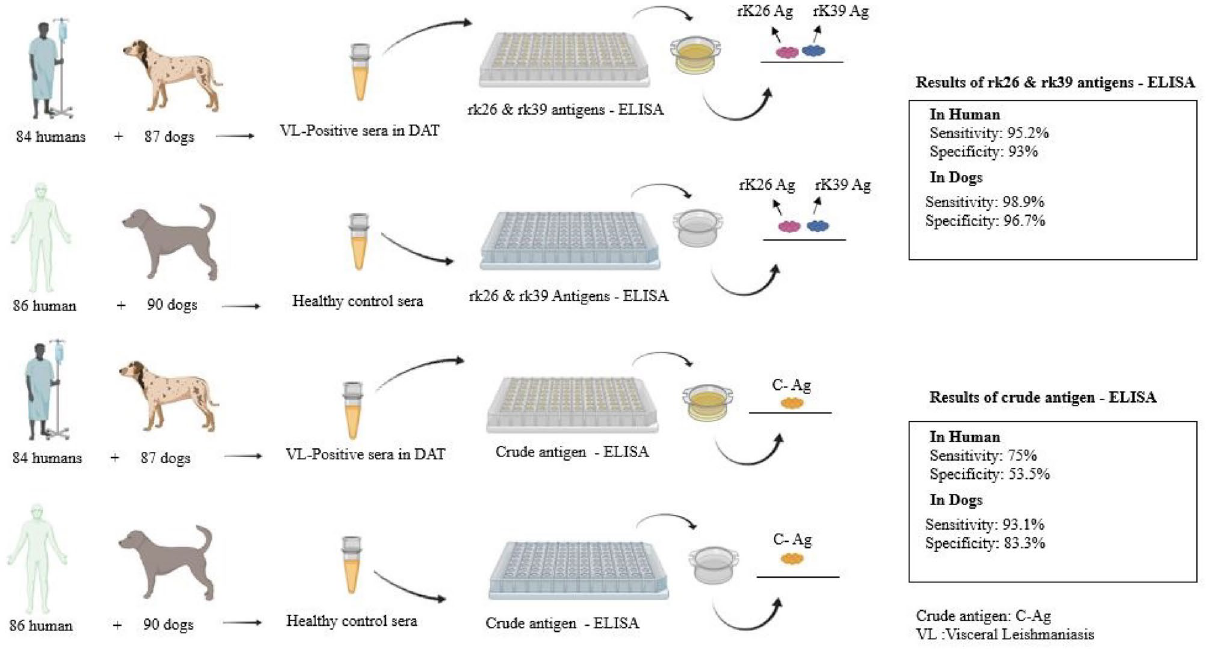
Figure 1. The results of the mixture of rK26 /rK39 and crude antigens from Iranian strain of Leishmania infantum to detect anti- Leishmania antibodies in human and reservoir